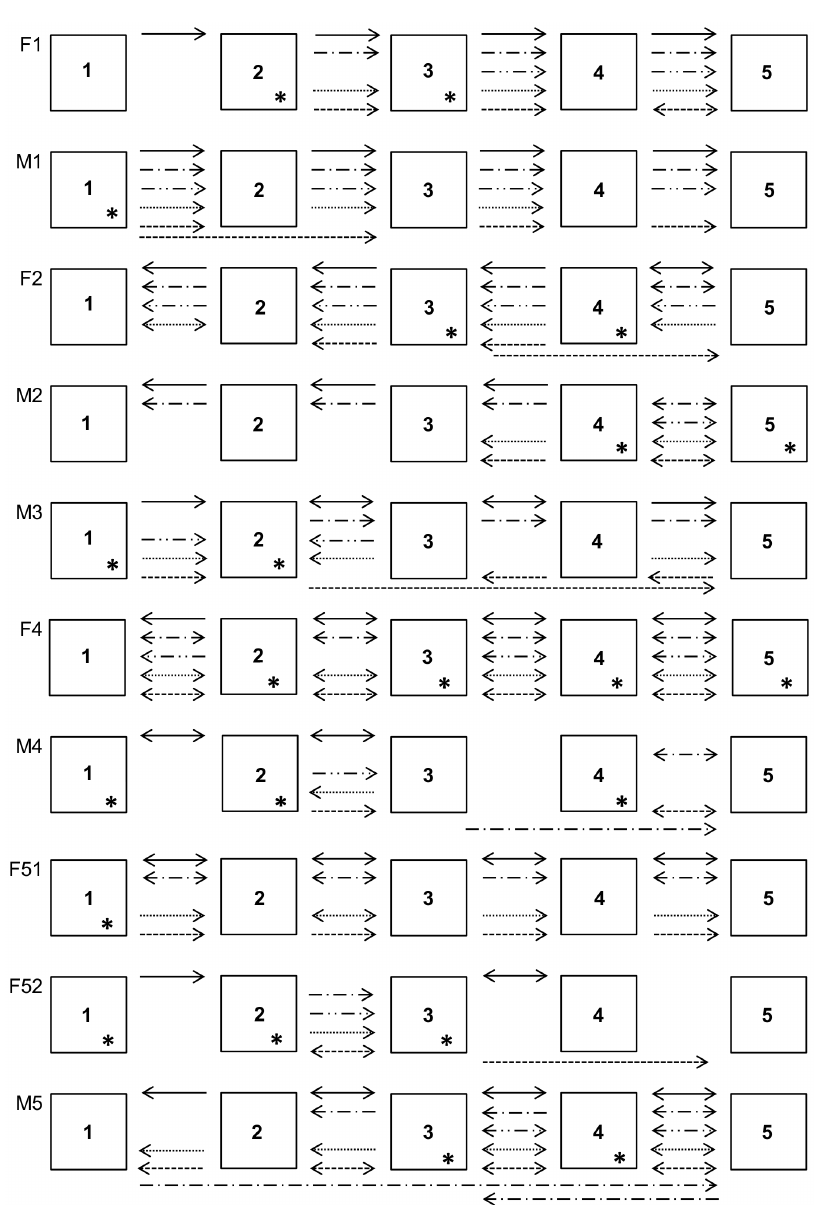
Fig. 3. Foraging routes followed by the study subjects in each experiment. Transitions between feeding boxes (arrows) performed with a frequency higher than expected by chance in each experiment. The arrow points from the source box to the target box. The double-headed arrows indicate that the transition was significant in both directions. Asterisks identify the boxes that were selected for first inspection at a frequency higher than expected by chance throughout the study. ___ 5 control, -.- 5 olfactory, -..- 5 visual, … 5 auditory, --- 5 spatial +